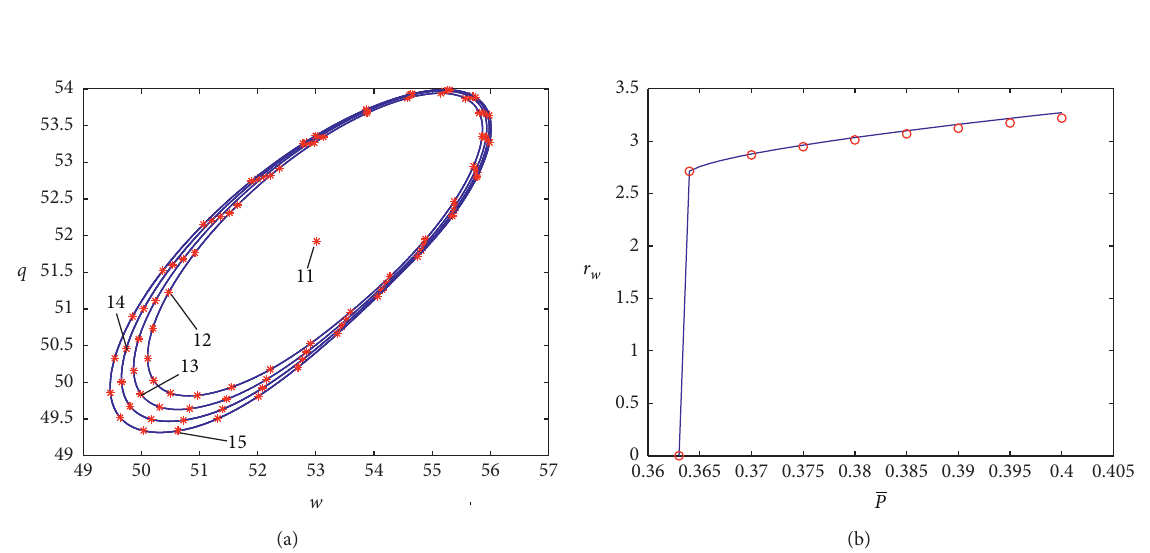
, l , l ,l , and l correspond to p � 0 . 363 ,p � 0 . 37 , p � 0 . 38 , p � 0 . 39 , 1 2 3 4 5